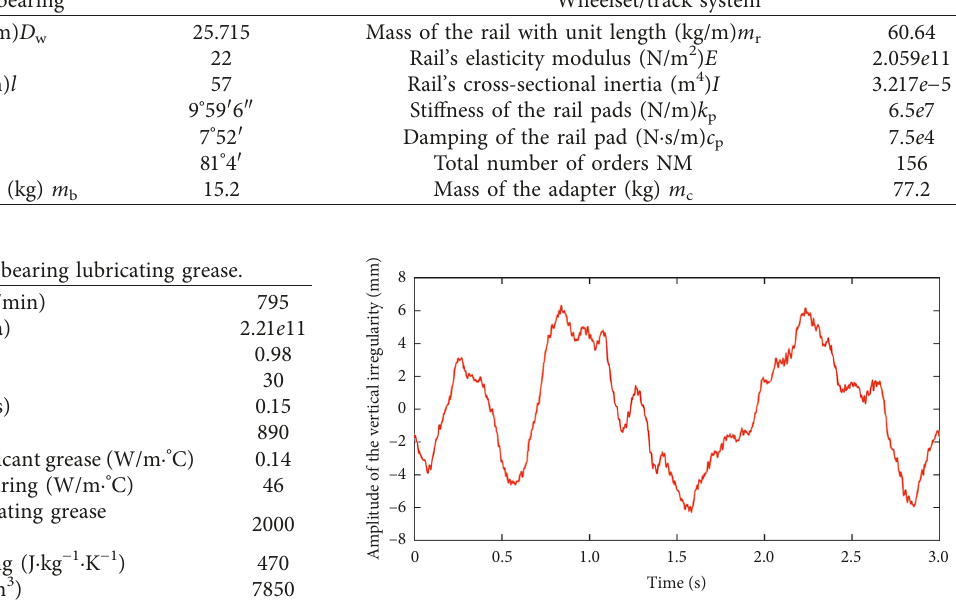
Figure 7: Vertical track irregularity